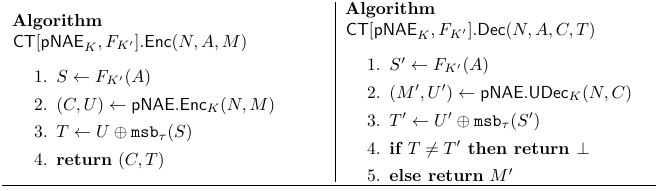
Figure 6: Ciphertext Translation.